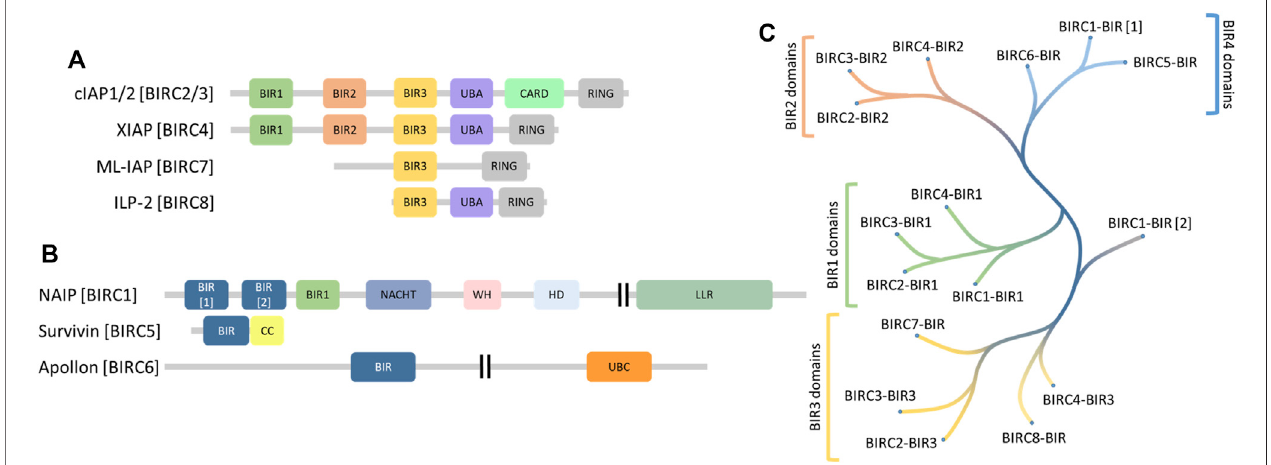
FIGURE 1 | (A) domain structure of the BIRC family E3 ligases displaying conservation of the BIR3 domain (yellow) and the RING domain (grey). (B) domain structure of the residual BIRC family members showing no conservation. (C) phylogenetic analysis of the BIR domains from all BIRC proteins showing clustering for the BIR1 (green), BIR2 (orange) and BIR3 (yellow) domains together with some ungrouped domains (blue). BIRC, Baculovirus IAP Repeat containing; BIR, Baculovirus IAP Repeat; UBA, Ubiquitin-associated; CARD, Caspase recruitment domain; RING, really interesting new gene; CC, Coiled coil; NACHT, NAIP, CIITA, HET-E und TEP1; WH, Winged helix; HD, Helical domain; UBC, Ubiquitin-conjugating; LLR, Leucine-rich